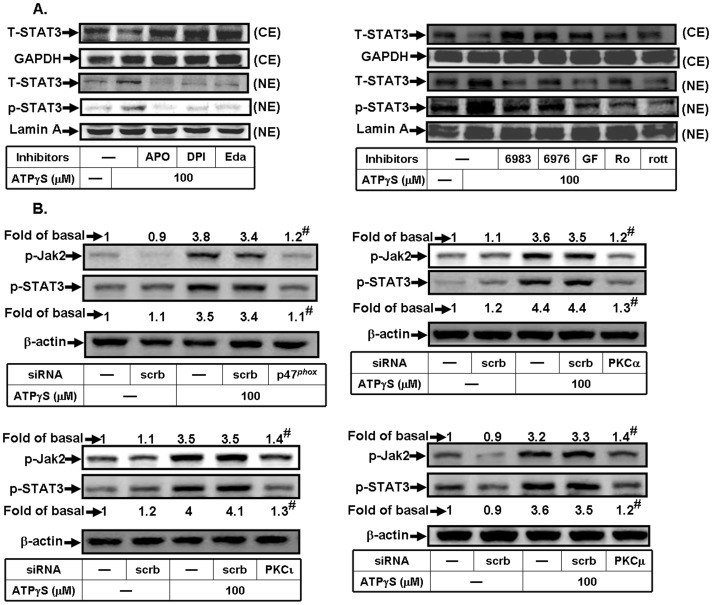
ATPγS regulates PKC/ROS-dependent Jak2 and STAT3 activation in A549 cells.(A) Cells were pretreated with APO (100 µM), DPI (10 µM), Edaravone (10 µM), Gö6983 (10 µM), Gö6976 (10 µM), GF109203X (3 µM), Ro318220 (10 µM), or Rottlerin (10 µM) for 1 h, and then incubated with ATPγS for 1 h. The cytosolic and nuclear fractions were prepared and subjected to Western blot analysis using an anti-phospho-STAT3 or anti-STAT3 antibody. (B) Cells were transfected with siRNAs of scrambled, p47phox, PKCα, PKCι, and PKCμ, and then incubated with ATPγS for 1 h. The cell lysates were subjected to western blot analysis using an anti-phospho-Jak2, anti-phospho-STAT3, or anti-β-actin antibody. Data are expressed as mean±S.E.M. of three independent experiments. #
p<0.01, as compared with the cells exposed to scrambled siRNA+ATPγS.